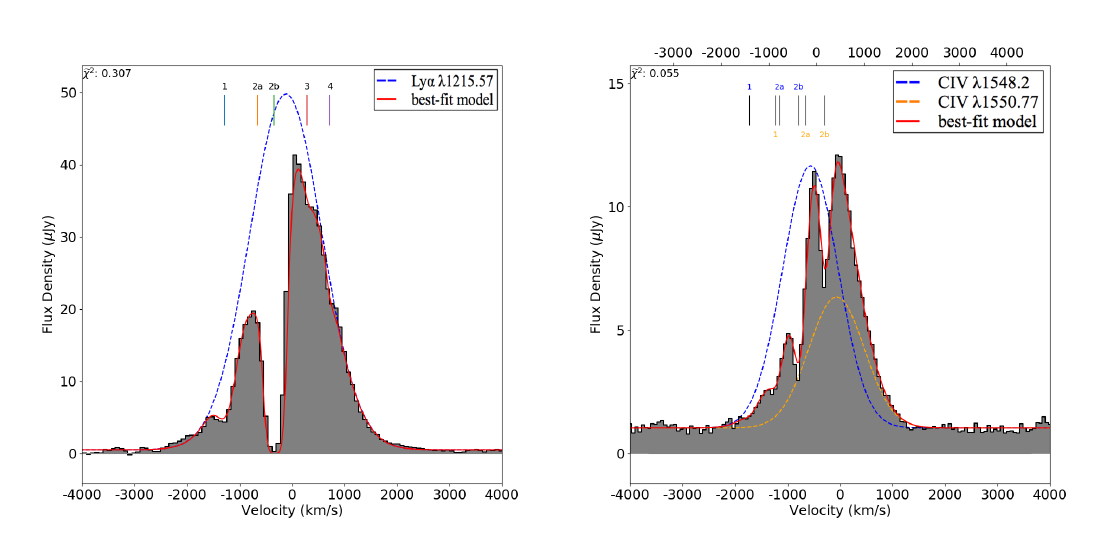
Figure 9. From Kolwa et al. in prep. Line emission in the same spectra as Figure 8, however with clear components of absorption as well. The absorbing components’ centroids are marked with vertical lines. Absorbing components 1, 2a, and 2b are seen in both the Ly α ( left ) and CIV ( right ) emission. The best fit models (red line) result from the Gaussian emission with multiple Gaussian absorption profiles. For the right figure, the velocity scale of the bottom ( top ) horizontal axis is set to zero at the blue (orange) Gaussian centroid, and each centroid has its absorption component centroids marked with corresponding font